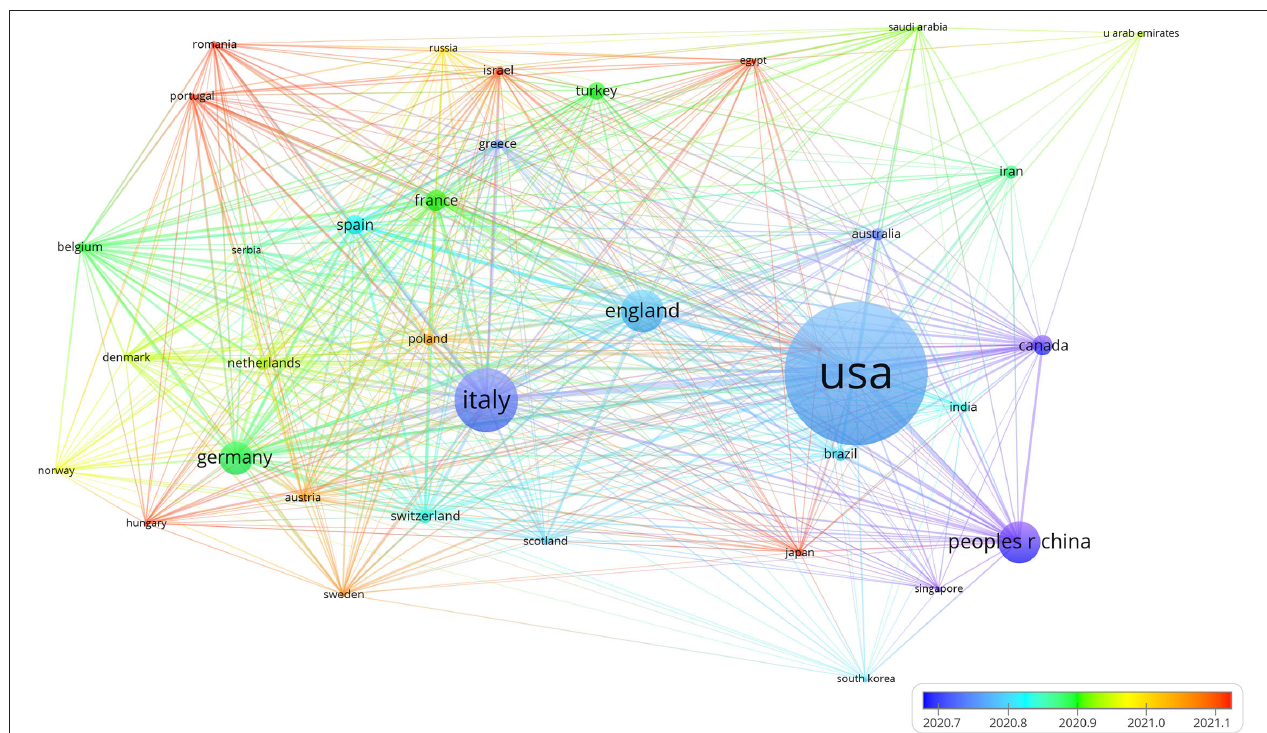
FIGURE 3 | The timeline view of the country distribution. Different colors represented different years. The warmer the color was, the closer the year. The distribution of cardiac disorders also reflected the dynamic change of critically ill patients in different countries. China, Italy, Canada, Singapore, USA, and England mainly carried out research on the cardiac involvement of COVID-19 in the early stage. With the epidemic of COVID-19, Spain, Switzerland, France, Germany, Israel, Russia, and other countries also began to focus on the cardiac disorder in COVID-19.